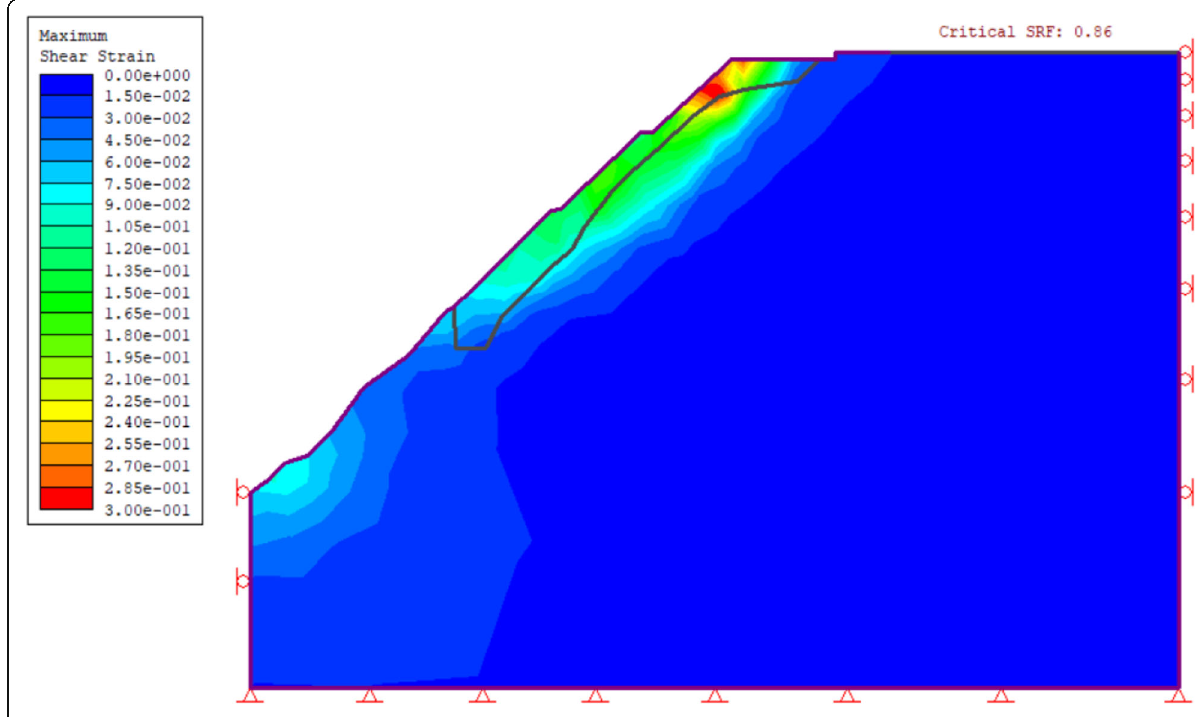
Fig. 11 Maximum shear stress for slope without